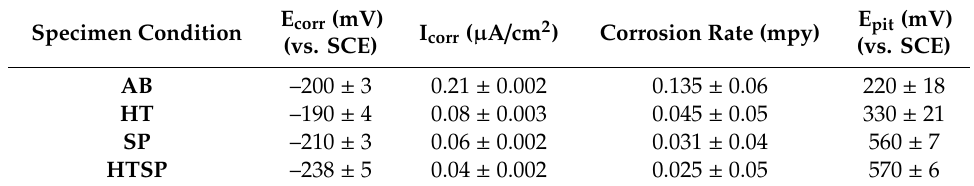
Table 3. Corrosion rate and pitting potential of SLM IN718 alloy in as-built, heat-treated, and / or shot-peened